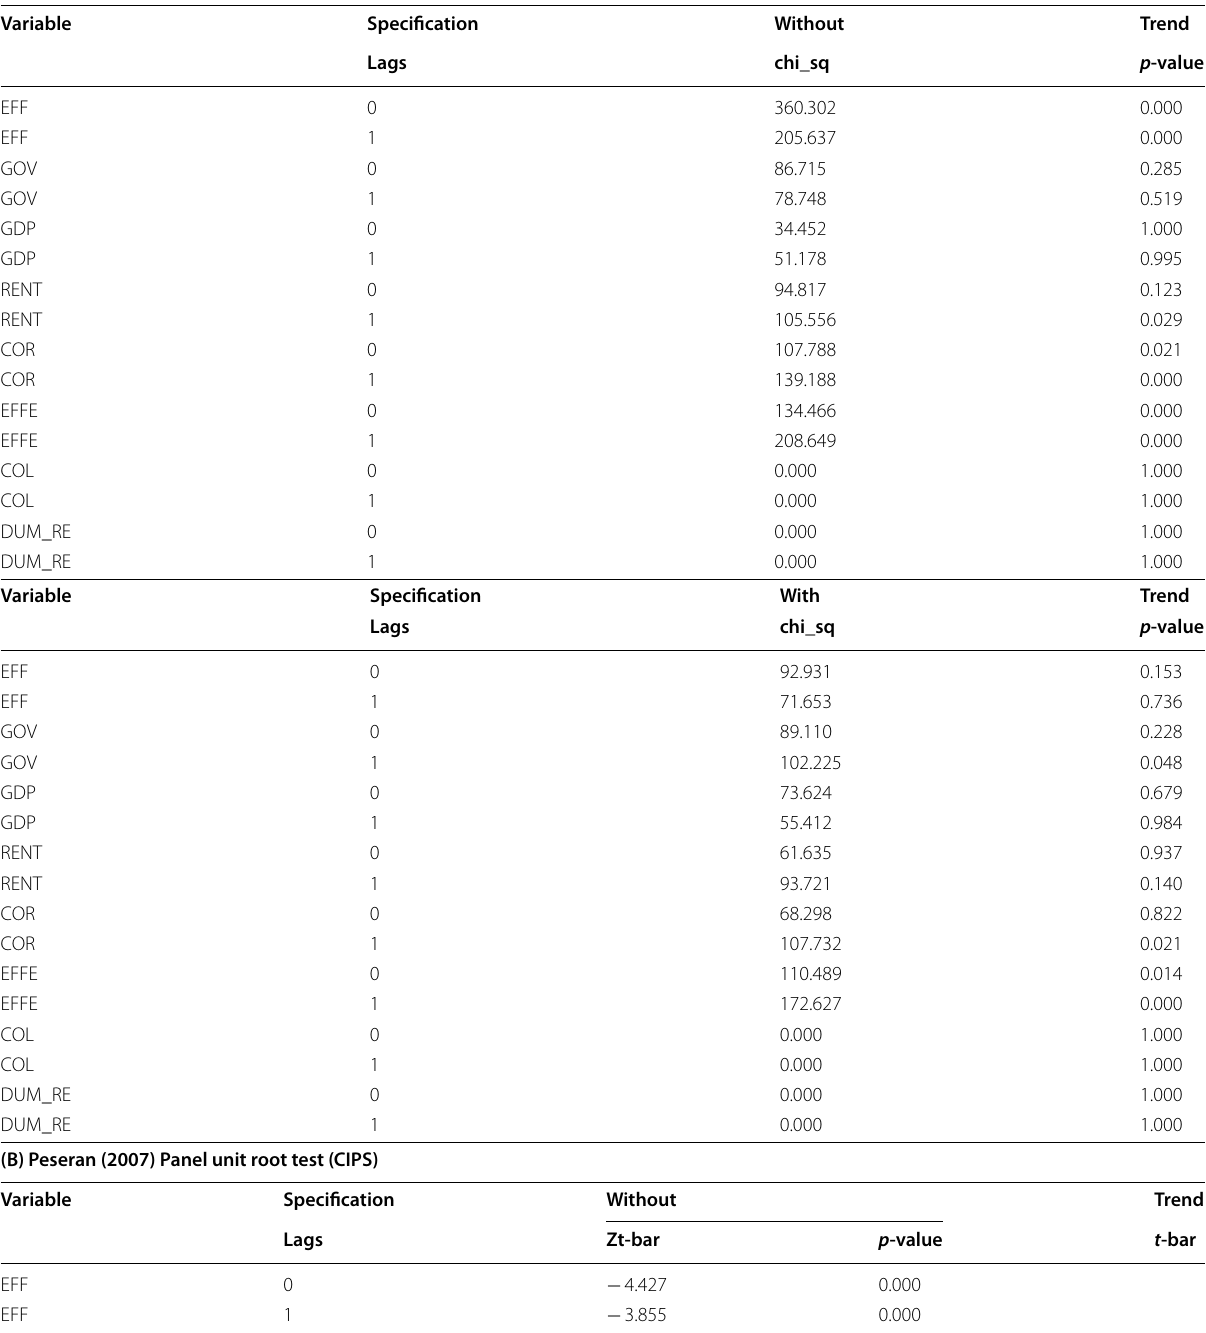
Table 6 Second generation unit root (A) Maddala and Wu (1999) Panel unit root test